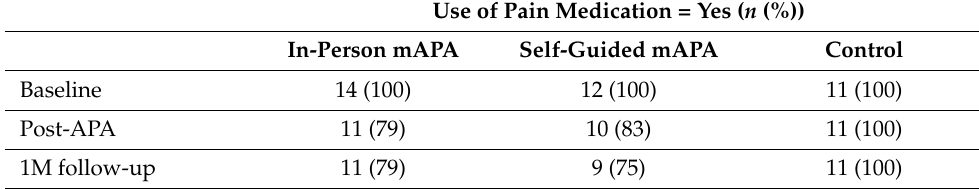
Table 2. Use of pain medication to manage CMP.